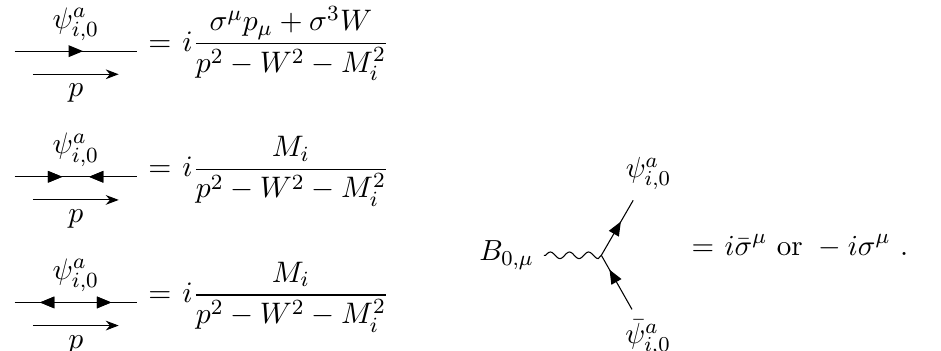
Figure 8. The Feynman rules for the physical Cartan fermions and PV regulators.